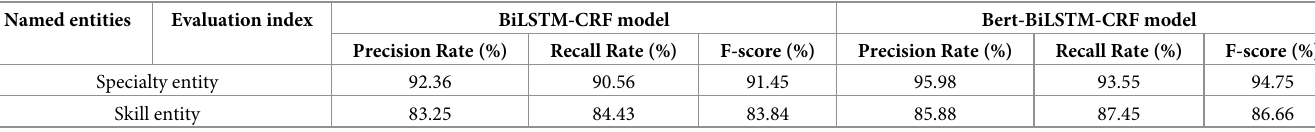
Table 2. Comparison of entity recognition results of